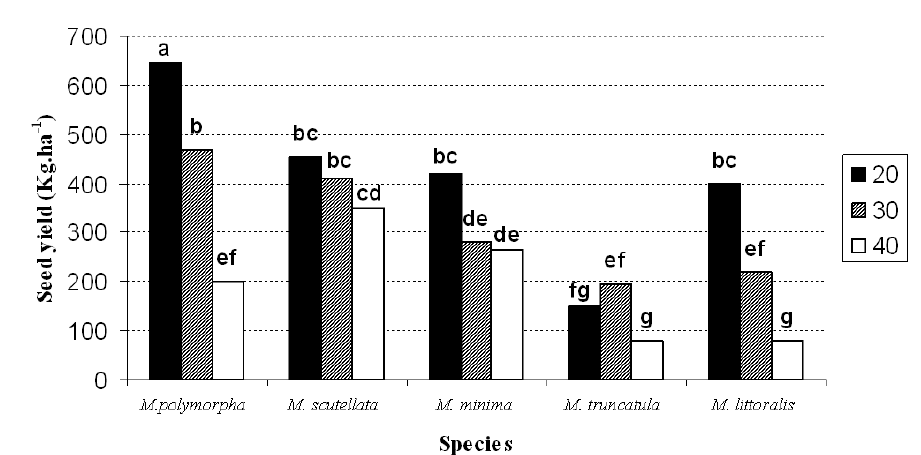
Fig. 4. Interaction effect between species and within row spacing on seed yield. All the values fol- lowed by the same letter in each column are not statistically different at the p<0.05 probability